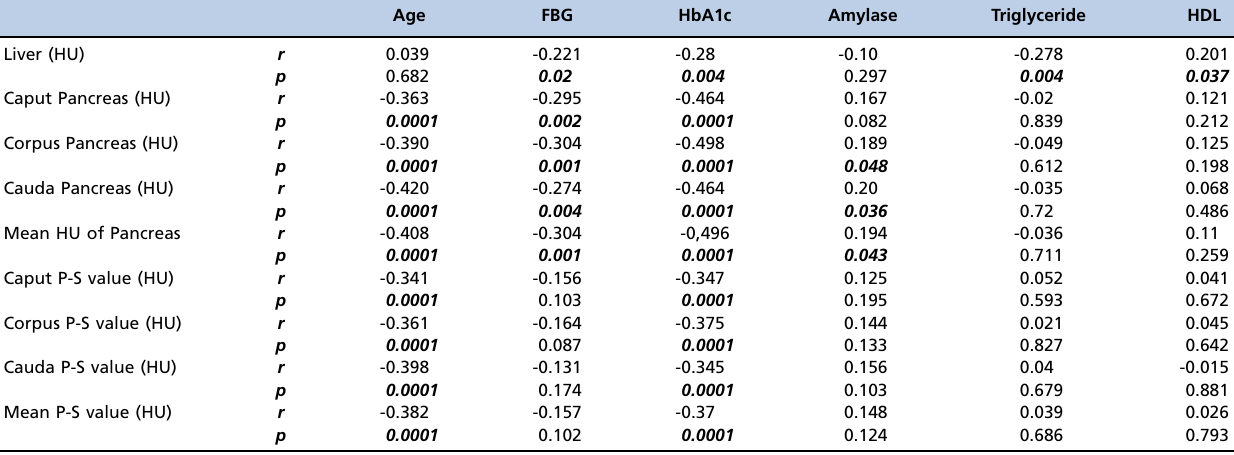
Table 4 - ANCOVA between-subjects effects. The dependent variable is the mean HU value of the pancreas adjusted for age. Source